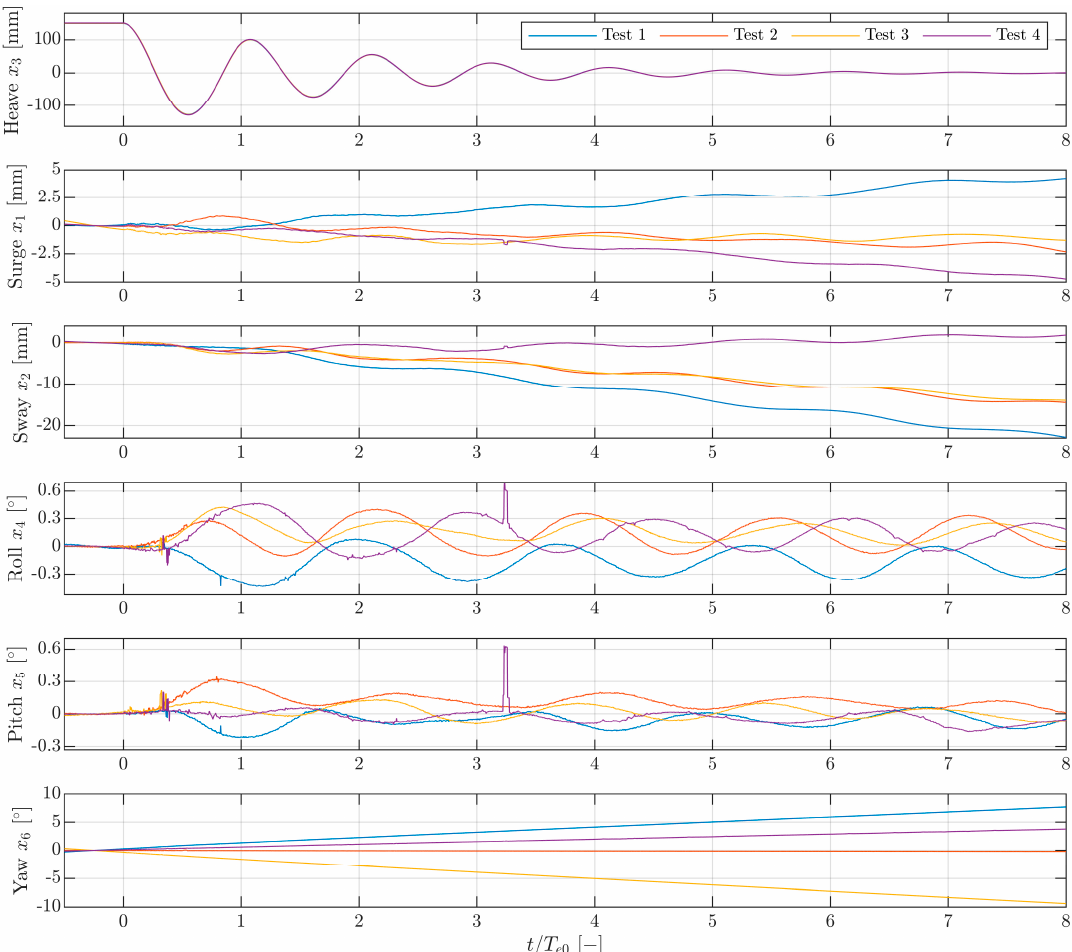
Figure 16. Measured six-DoF motion time series for H 0 = 0.5 D